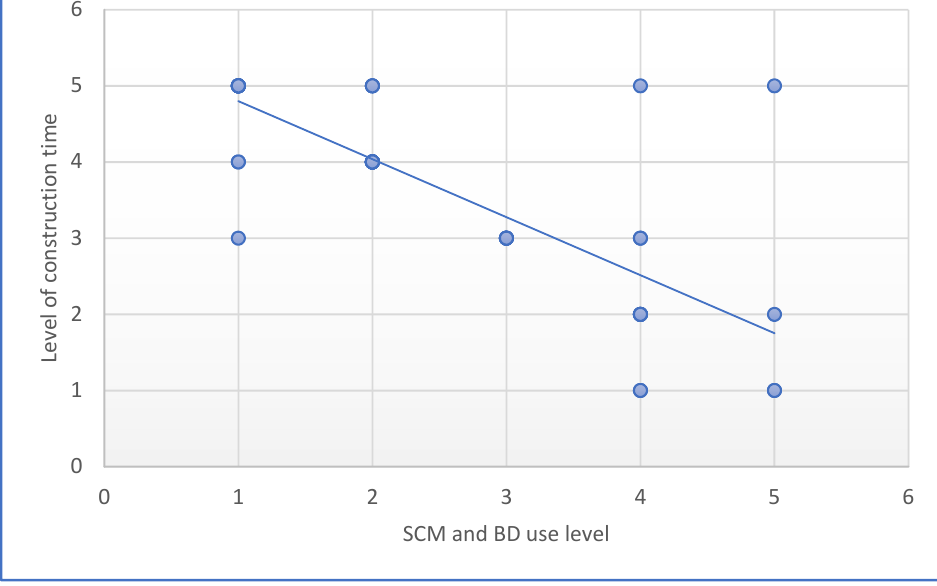
Figure 4. Relationship between SCM and BD use level and level of construction time.